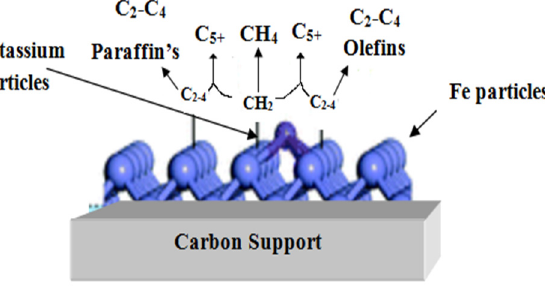
Figure 6. Mechanism of a carbon-supported iron catalyst containing potassium as a